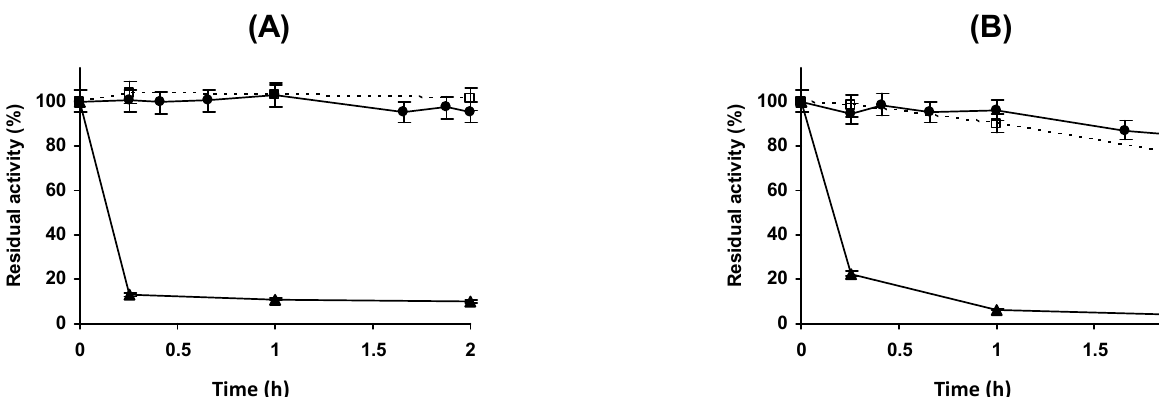
Figure 9. Thermal inactivation of r Aae UPO immobilized on MANAE agarose support. Inactivation was performed in 10 mM Tris at pH 7.0 and 57 °C. Other specifications can be found in the Methods section. Full circles: MANAE agarose biocatalyst; empty squares with dotted line: free enzyme.